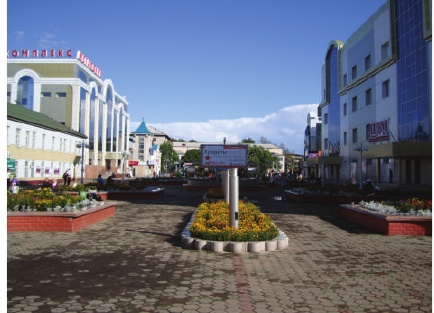
Figure 10: Main street in Birobidzhan (zone 2).